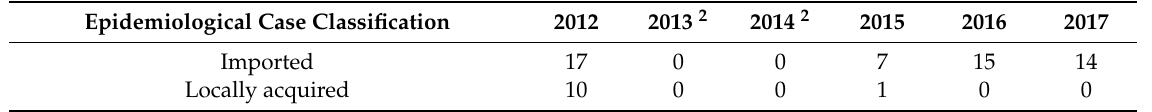
Table 3. Number of reported malaria cases 1 by epidemiological case classification, Evrotas Municipality, 2012–2017.